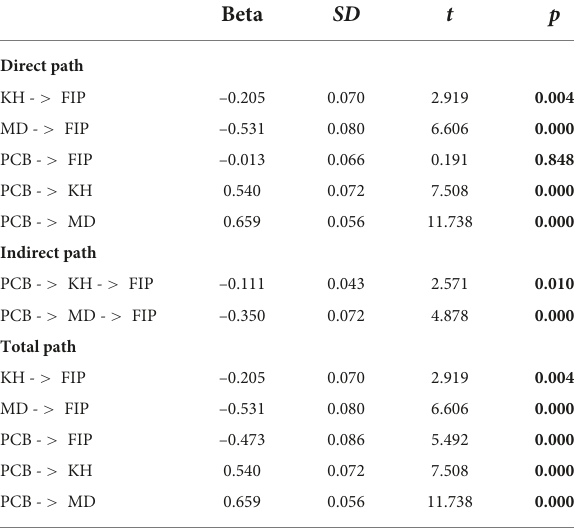
TABLE 4 Direct, indirect and total path estimates (mediation).